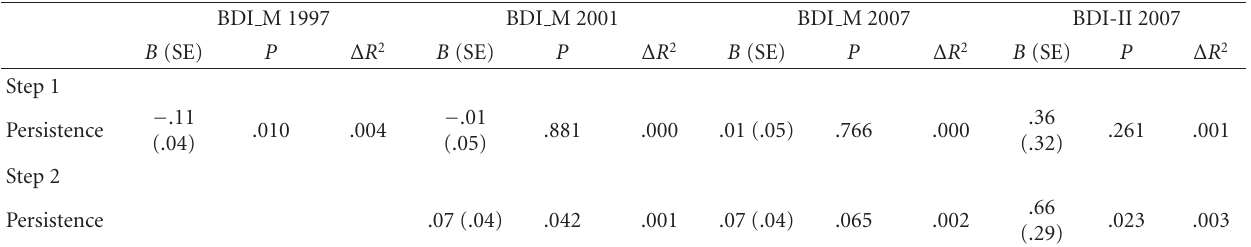
Table 4: Regression coe ffi cients of persistence predicting depressive